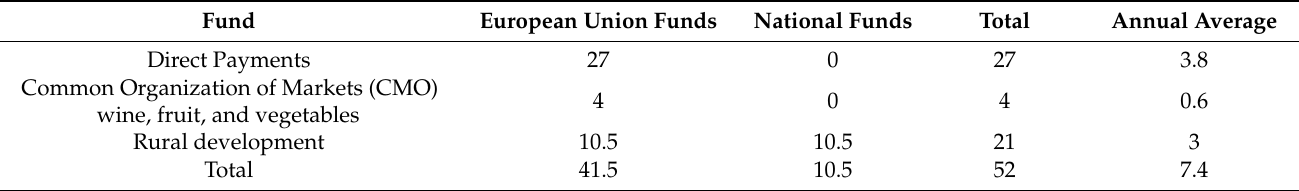
Table 1. Common Agricultural Policy (CAP) funding to Italy from 2014 to 2020 (billion euros) (Source: Ministry of Agricultural, Food and Forestry